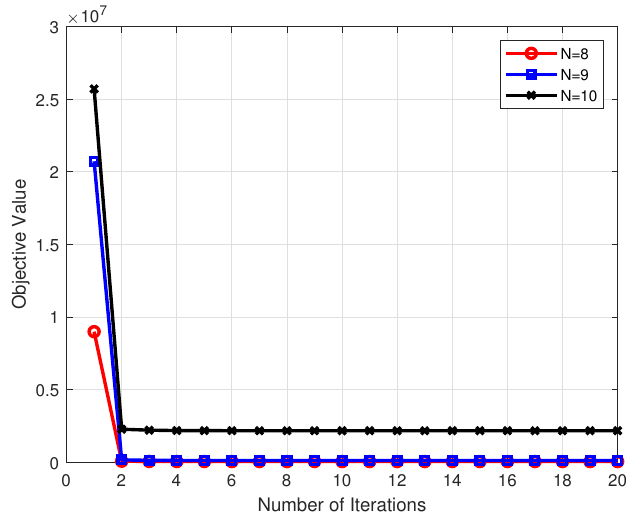
Figure 8. Convergence of the bisection search-based algorithm.